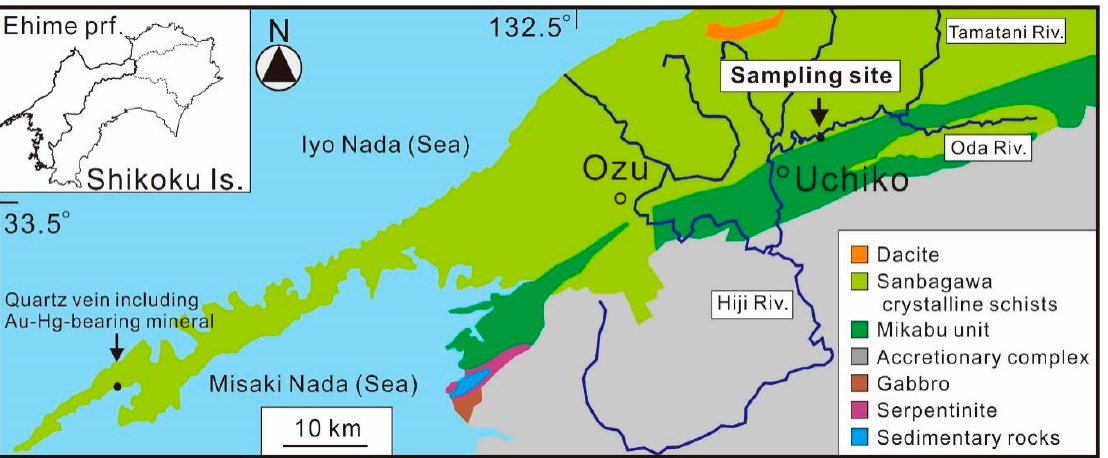
Figure 2. ( a ) Photographic image of aurihydrargyrumite (silver material); ( b ) backscattered electron image of a grain cross section; and, ( c ) backscattered electron image of the surface of the grain.